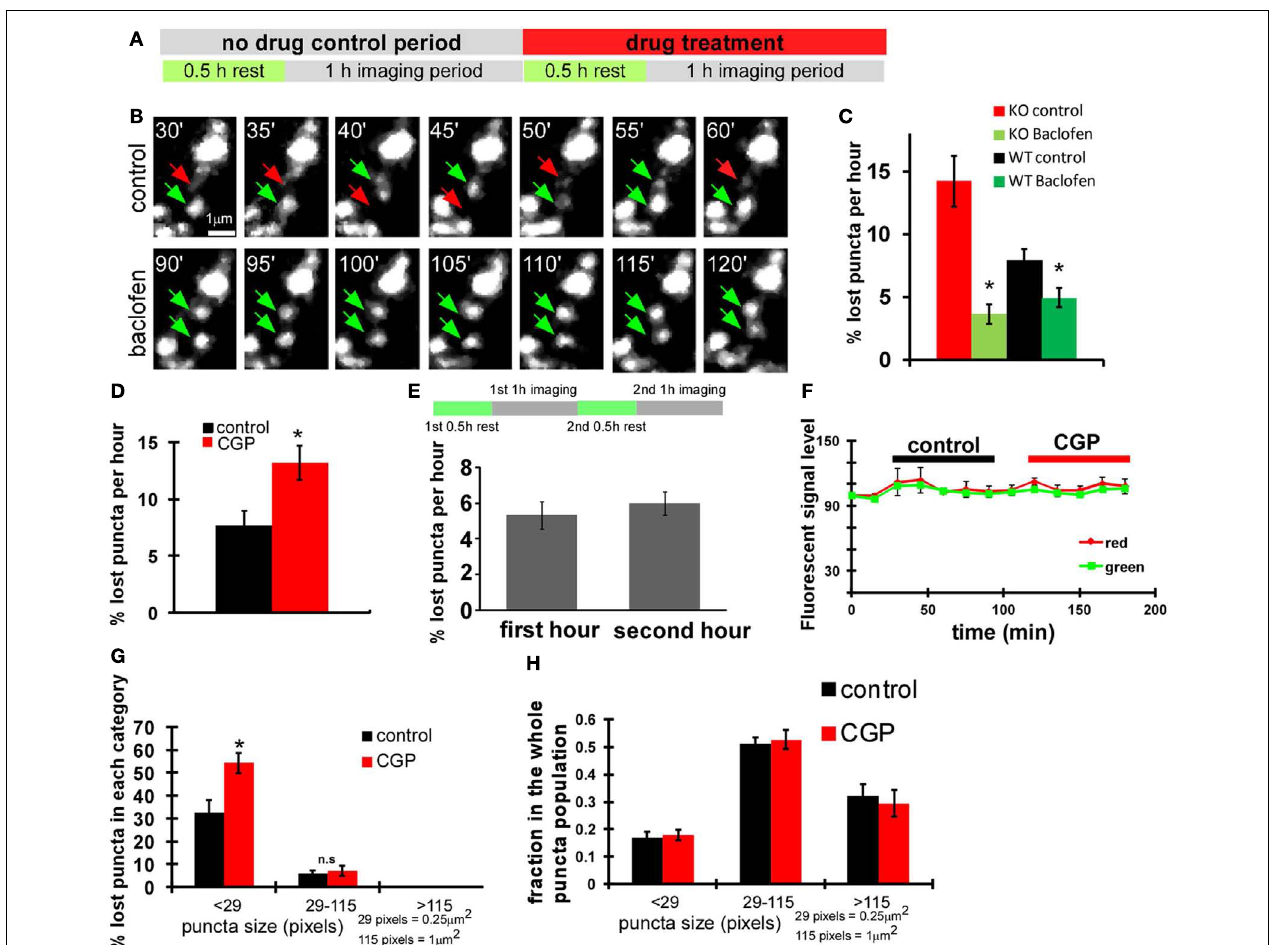
Cortical PV neurons were labeled with LSL-syn-GFP and LSL-DsRed using slice cultures from PV-ires-Cre mice.The two imaging sessions were conducted as depicted in the diagram, and the lost syn-GFP puncta were quantified ( n = 3 cells). (F) CGP treatment did not significantly quench fluorescence protein signal. For neurons analyzed in (D,E) , syn-GFP and RFP intensity on 10 randomly picked boutons were followed for all time points.The change of fluorescence levels on the same bouton was analyzed by normalizing with the initial fluorescence signal, which was normalized as 100. (G) For neurons imaged in (D) , the percentage of lost puncta was plotted according to their size described in Figure 3F ( n = 6 cells, t -test P = 0.001). (H) Acute CGP treatment did not change the puncta size distribution. For neurons analyzed in Figure 4D, puncta were classified according to size.The fraction of each size category over the whole puncta population was calculated and plotted.The analysis was done for the 30- and 180-min time points, according to the X axis in (F) ( n = 3